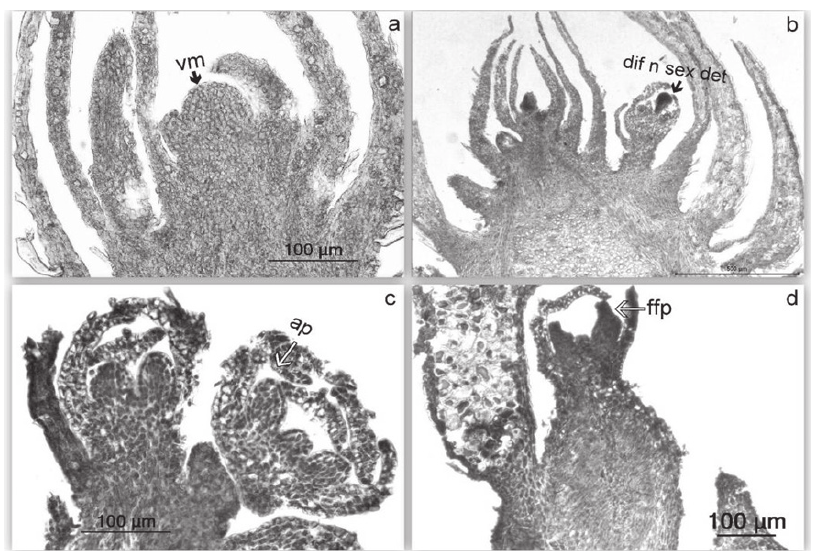
FiGure 2. Histological longitudinal sections of key bud stages: a) vegetative bud (vm - vegetative meristem), b) differentiated bud without sexual determination (dif n sex det), c) primordial of male inflorescence (ap - anther primordium), d) female inflorescence (ffp - female flower primordium).